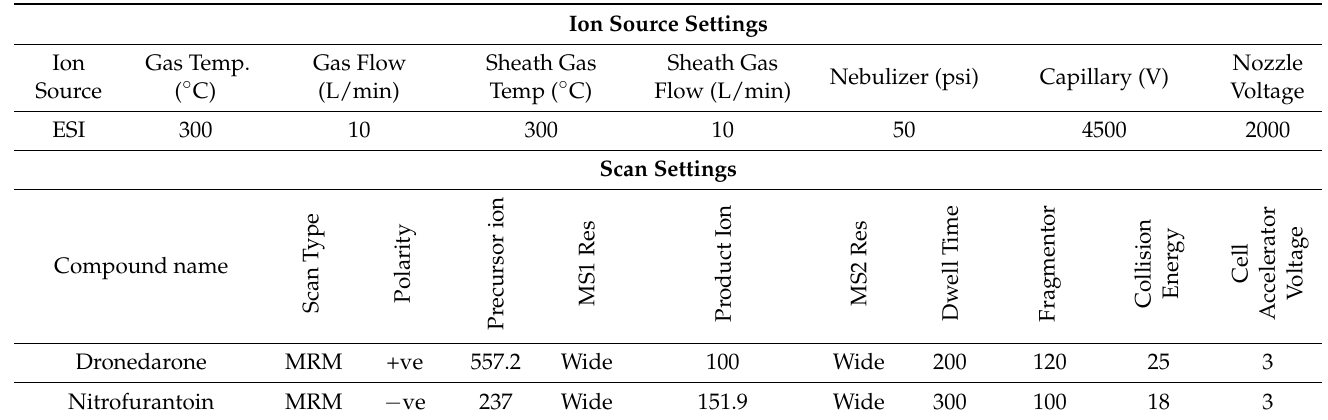
Table 2. LC-MS/MS parameters selected for quantification of dronedarone using nitrofurantoin as internal